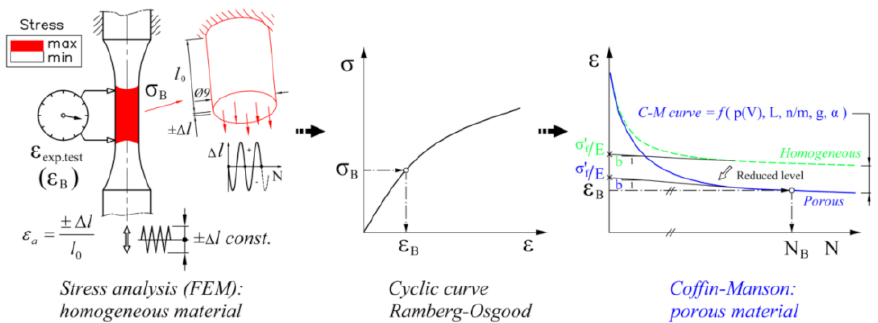
Figure 2. Sequential steps in predicting the fatigue life N of a porous structure using Method B.